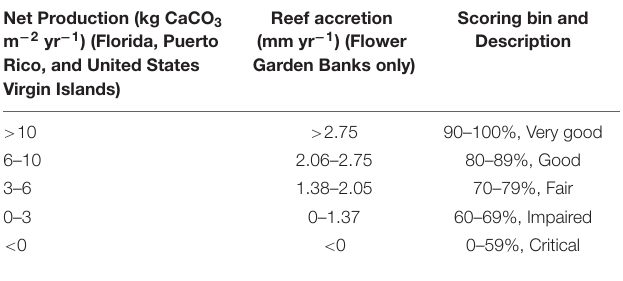
( Table 6 ). Percentage scores for Human Connections